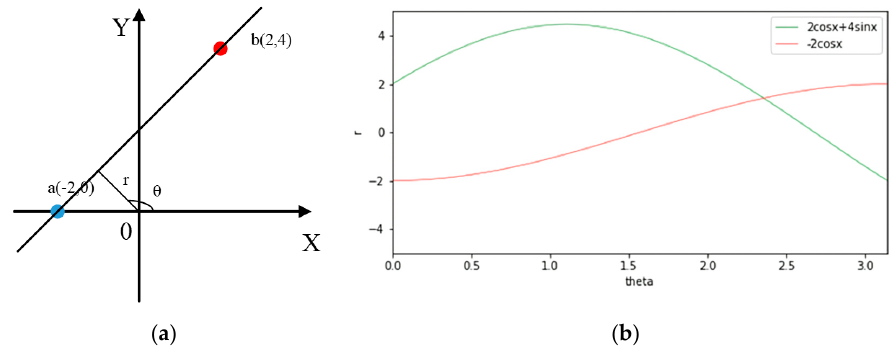
Figure 4. Polar coordinate parameter space . ( a ) r and θ in polar coordinates; ( b ) the curve intersection in the parametric space.